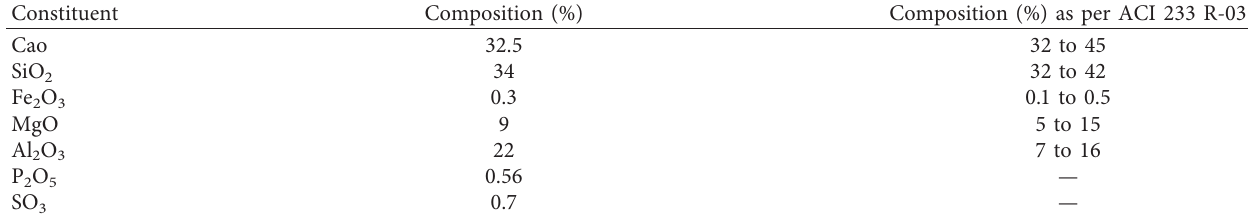
Table 1: Chemical composition of steel slag.